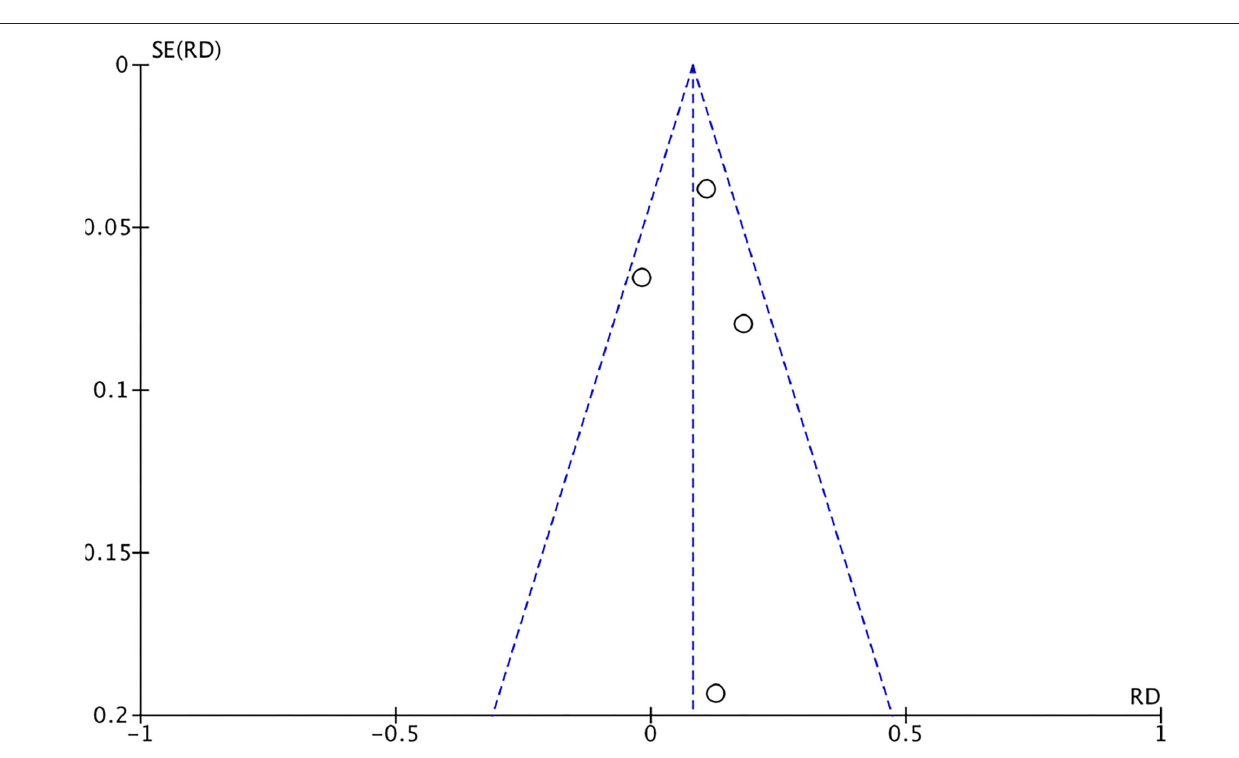
FIGURE 7 | Funnel plot of the efficacy of the two drug regimens analyzed in the